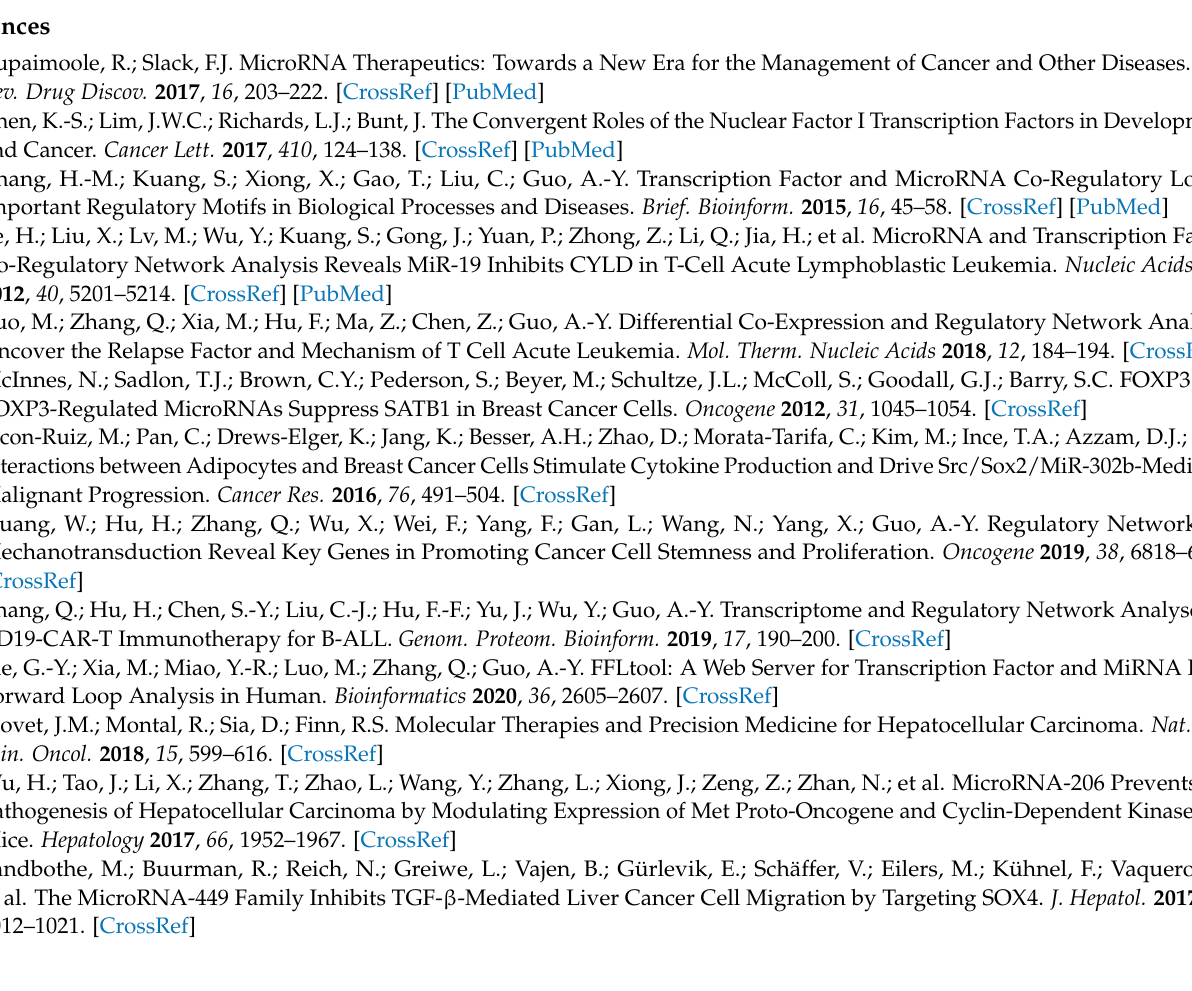
Figure S4: Potential downstream genes of CPEB3; Figure S5: Gene expression in different pathological stages; Table S1: Read statistics and quality control of RNA-seq. This table shows read counts and quality control of RNA-Seq sequencing data for FOXO1 overexpression and controls; Table S2: Differentially expressed genes and miRNAs; Table S3: Sequences of primers for real-time qPCR and oligonucleotides in this study; Table S4: Clinical characteristics of 368 patients of liver hepatocellular carcinoma from